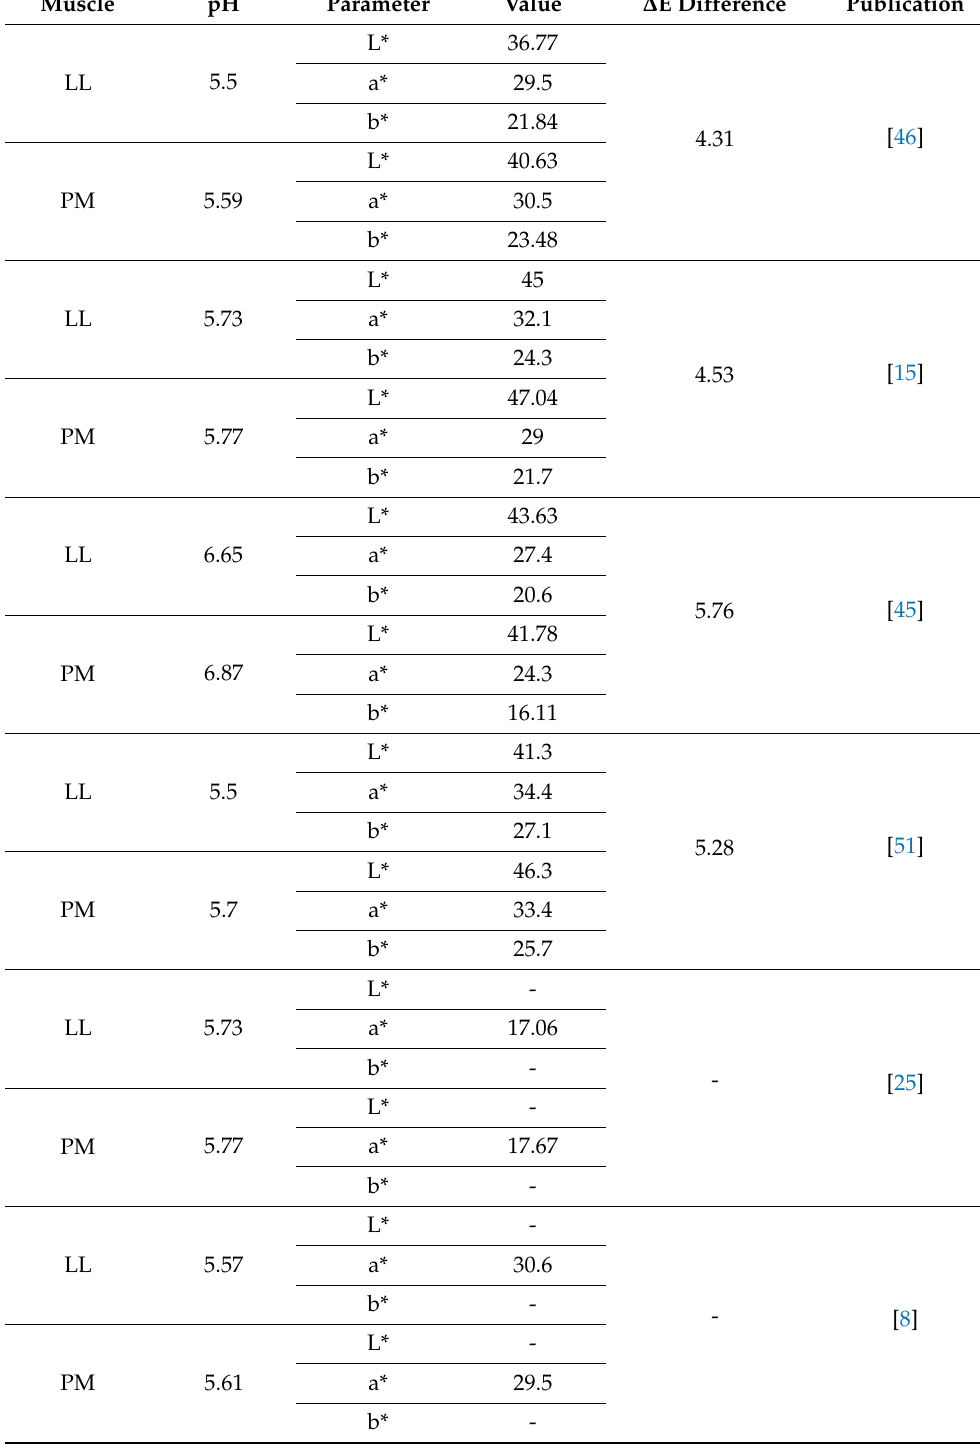
Table 1. Color and pH differentiation between color-stable and color-unstable muscles in fresh beef. Muscle pH Parameter Value ∆ E